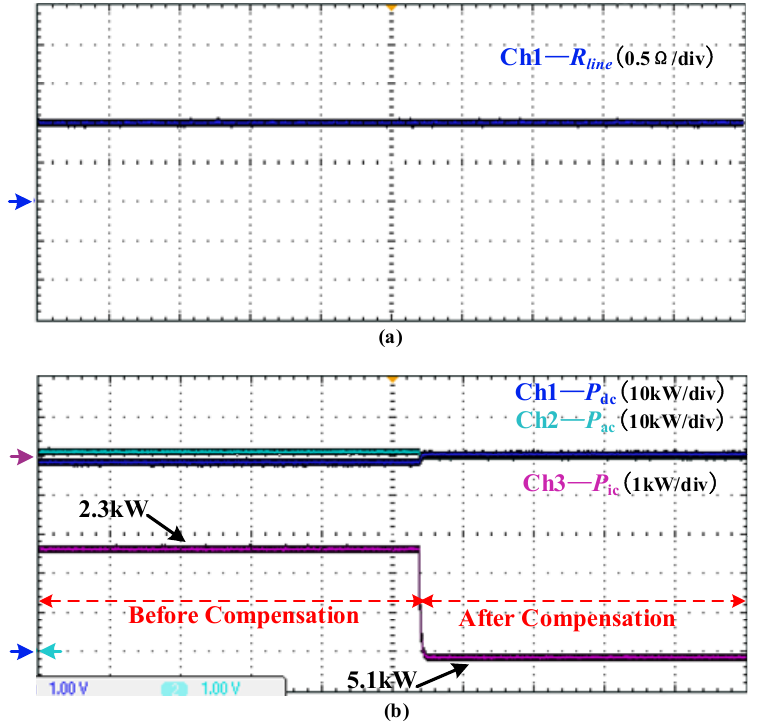
Figure 9. Experimental results when R line = 1 Ω ( x -axis: time, 1 s/div; y -axis: magnitude of the measured signal): ( a ) estimated resistance; ( b ) output power of sub-grids and IC.